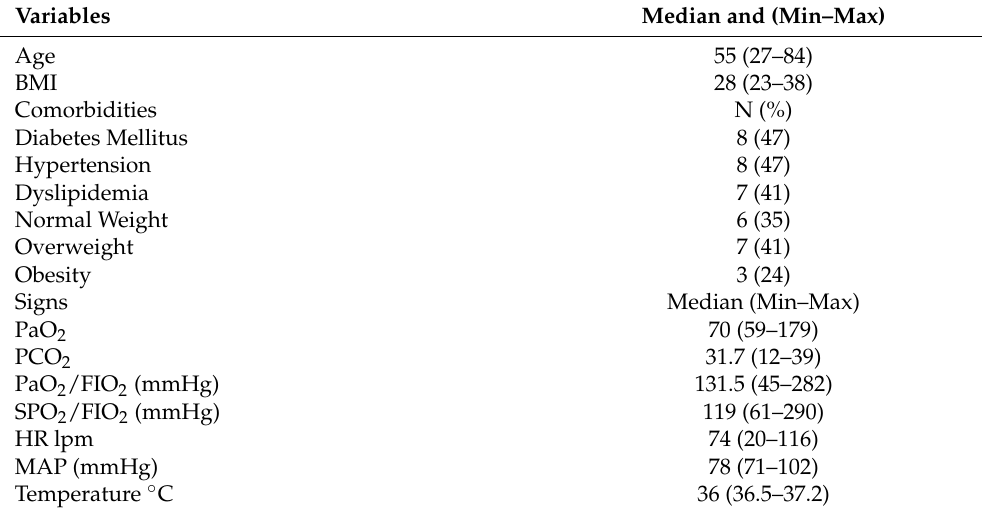
Table 1. Demographic characteristics at admission in patients infected with SARS-CoV-2 before the NAC